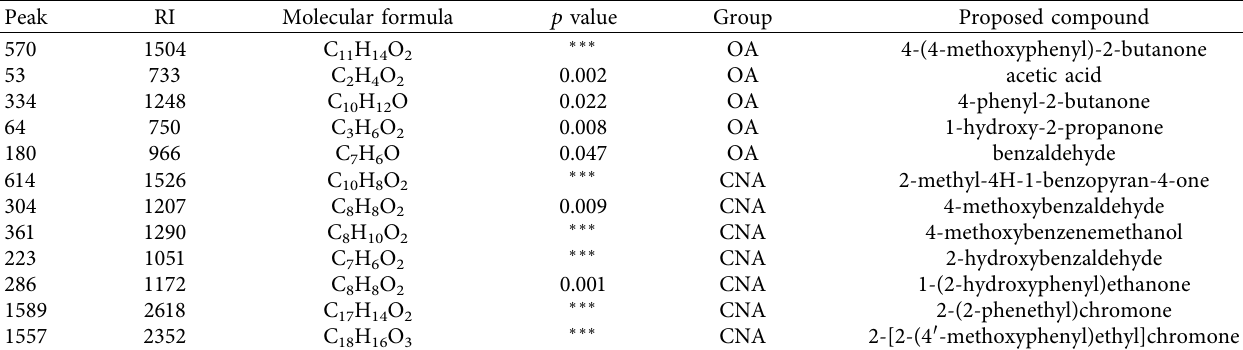
Table 3: Twelve distinguished compounds between CNA and OA in terms of violate constituents.